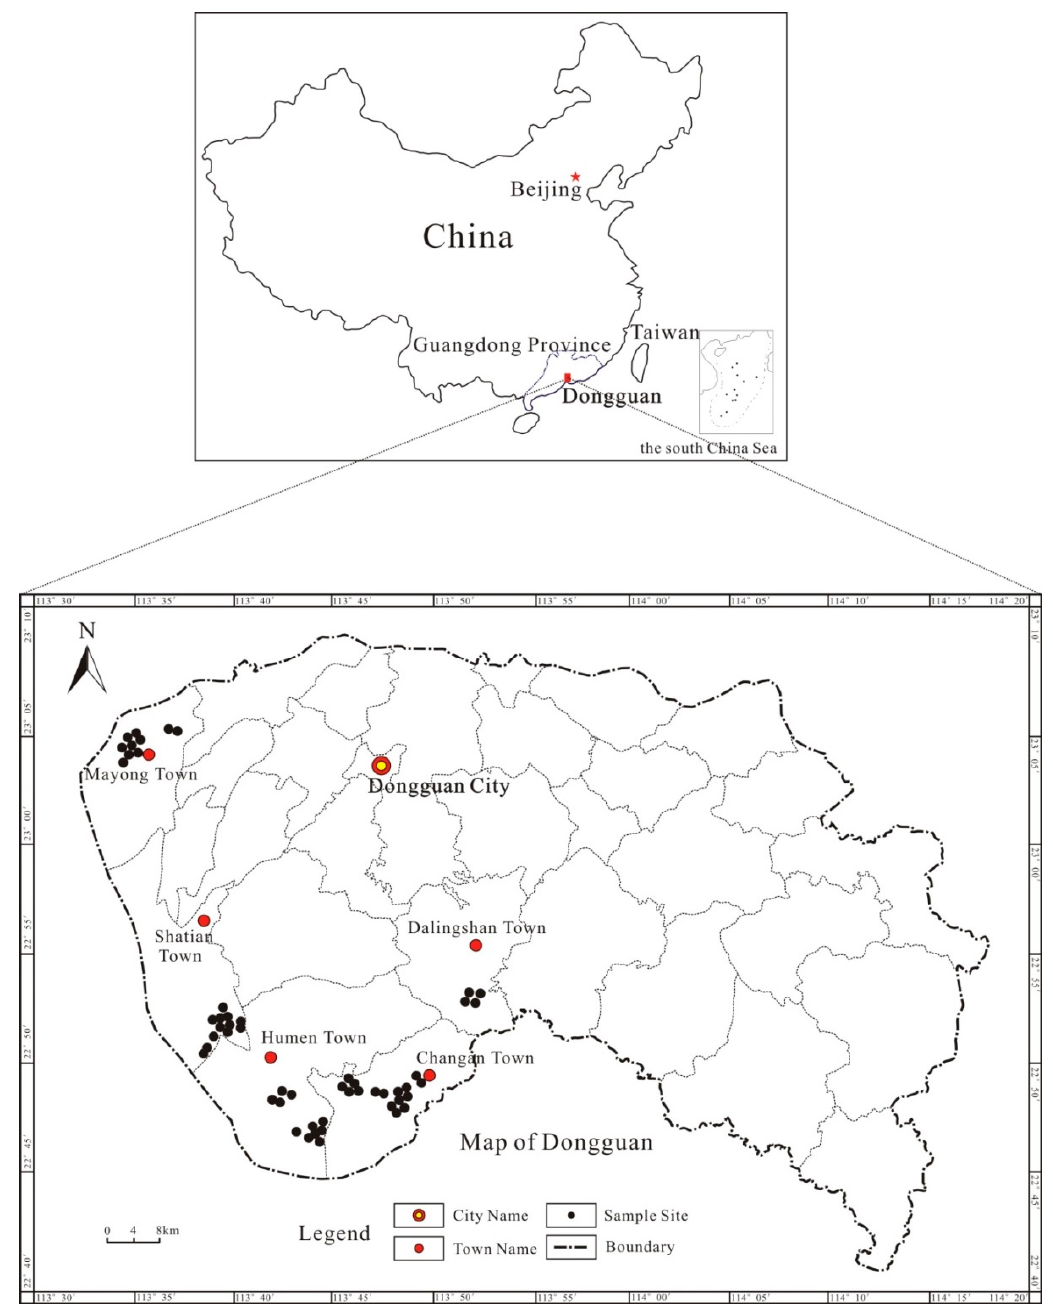
Figure 1. The location of the study area and distribution of sampling sites.